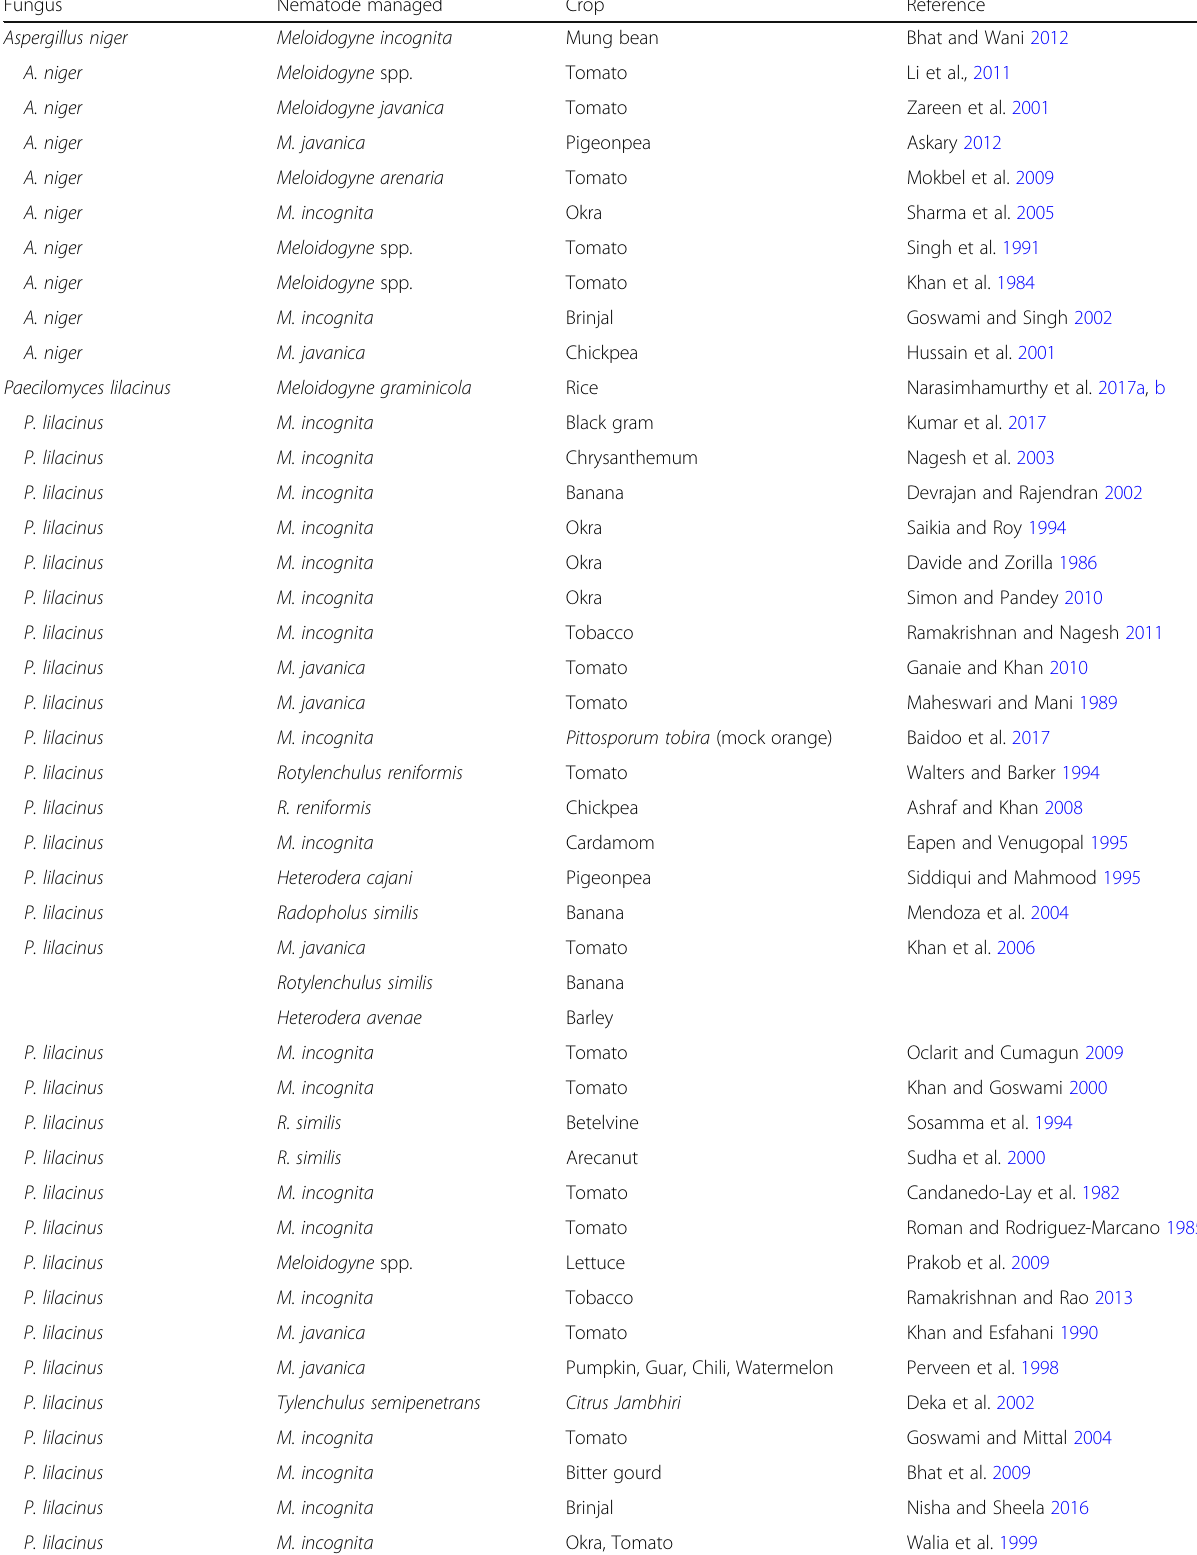
Table 4 Biocontrol agents of fungal species targeting nematodes on economic crops